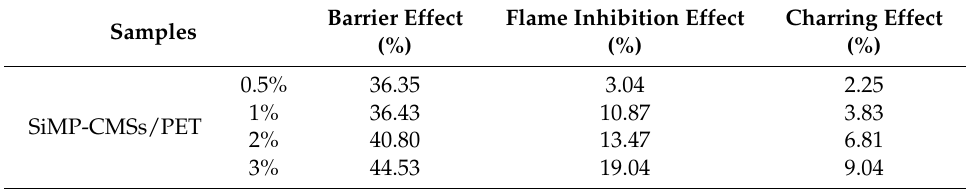
Table 4. Quantitative comparison of flame-retardant modes for SiMP-CMSs/PET composites.